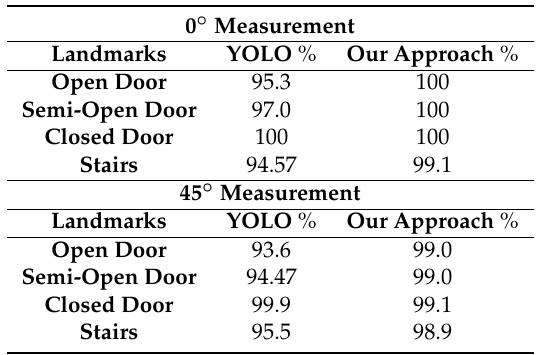
Table 5. Comparison accuracy values with YOLO (You Only Look